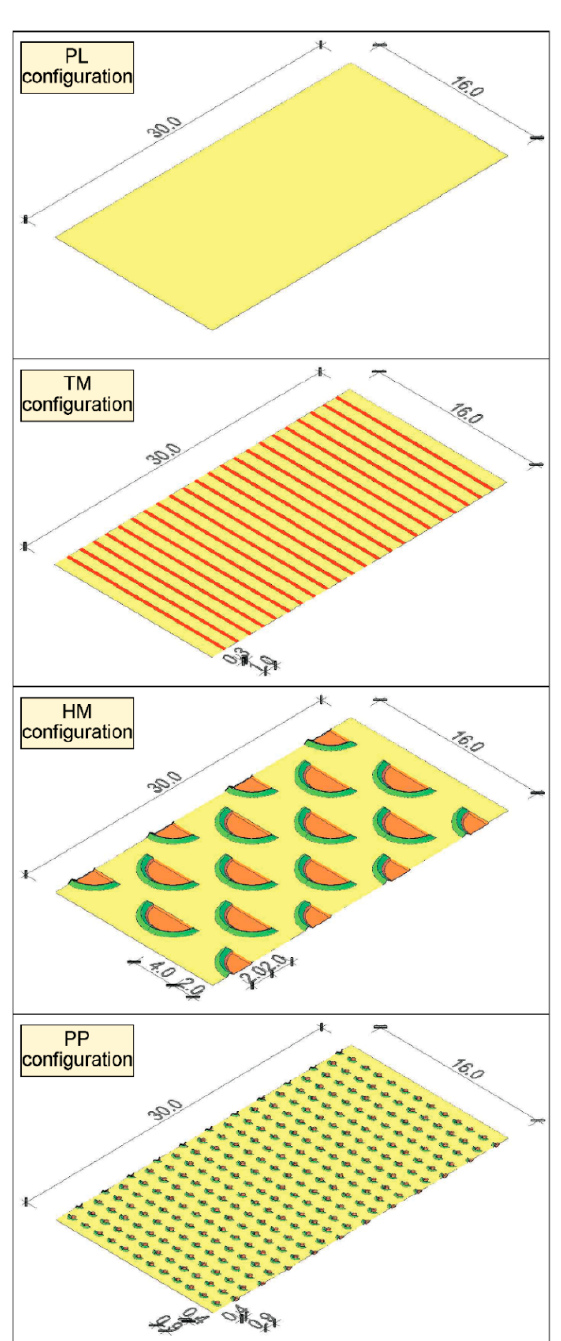
Figure A1. Geometrical characteristics of the spatial domains used for simulations. All measures are in meters. All plots present a constant slope of 1% towards downstream. Coloring: red represents the treated surfaces (tilled areas), green displays ridges (realized from the excavated terrain), yellow shows the untreated surfaces (crusted areas).